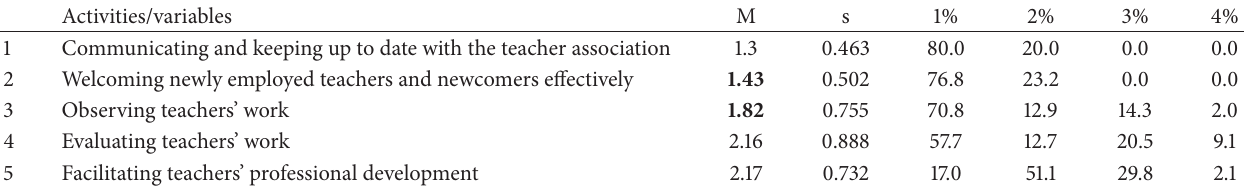
Table 3: The significance of activities related to the management and development of their educative